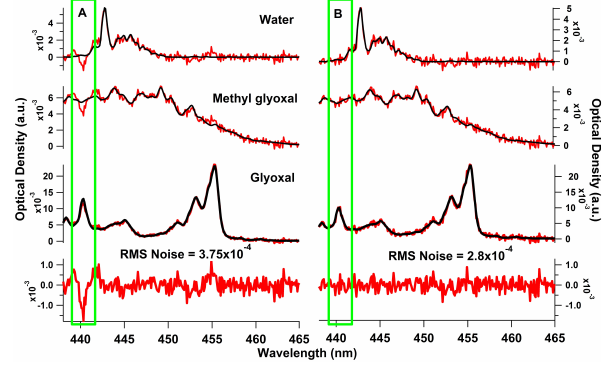
Fig. 5. Effects of wavelength dependent path length on the fit resid- ual. (A) An unscaled glyoxal cross-section is fitted to the spectra. (B) Scaled glyoxal cross-section fit (Eqs. 5 and 6, Rayleigh case in N 2 ). Cross-section scaling is able to reduce the RMS by